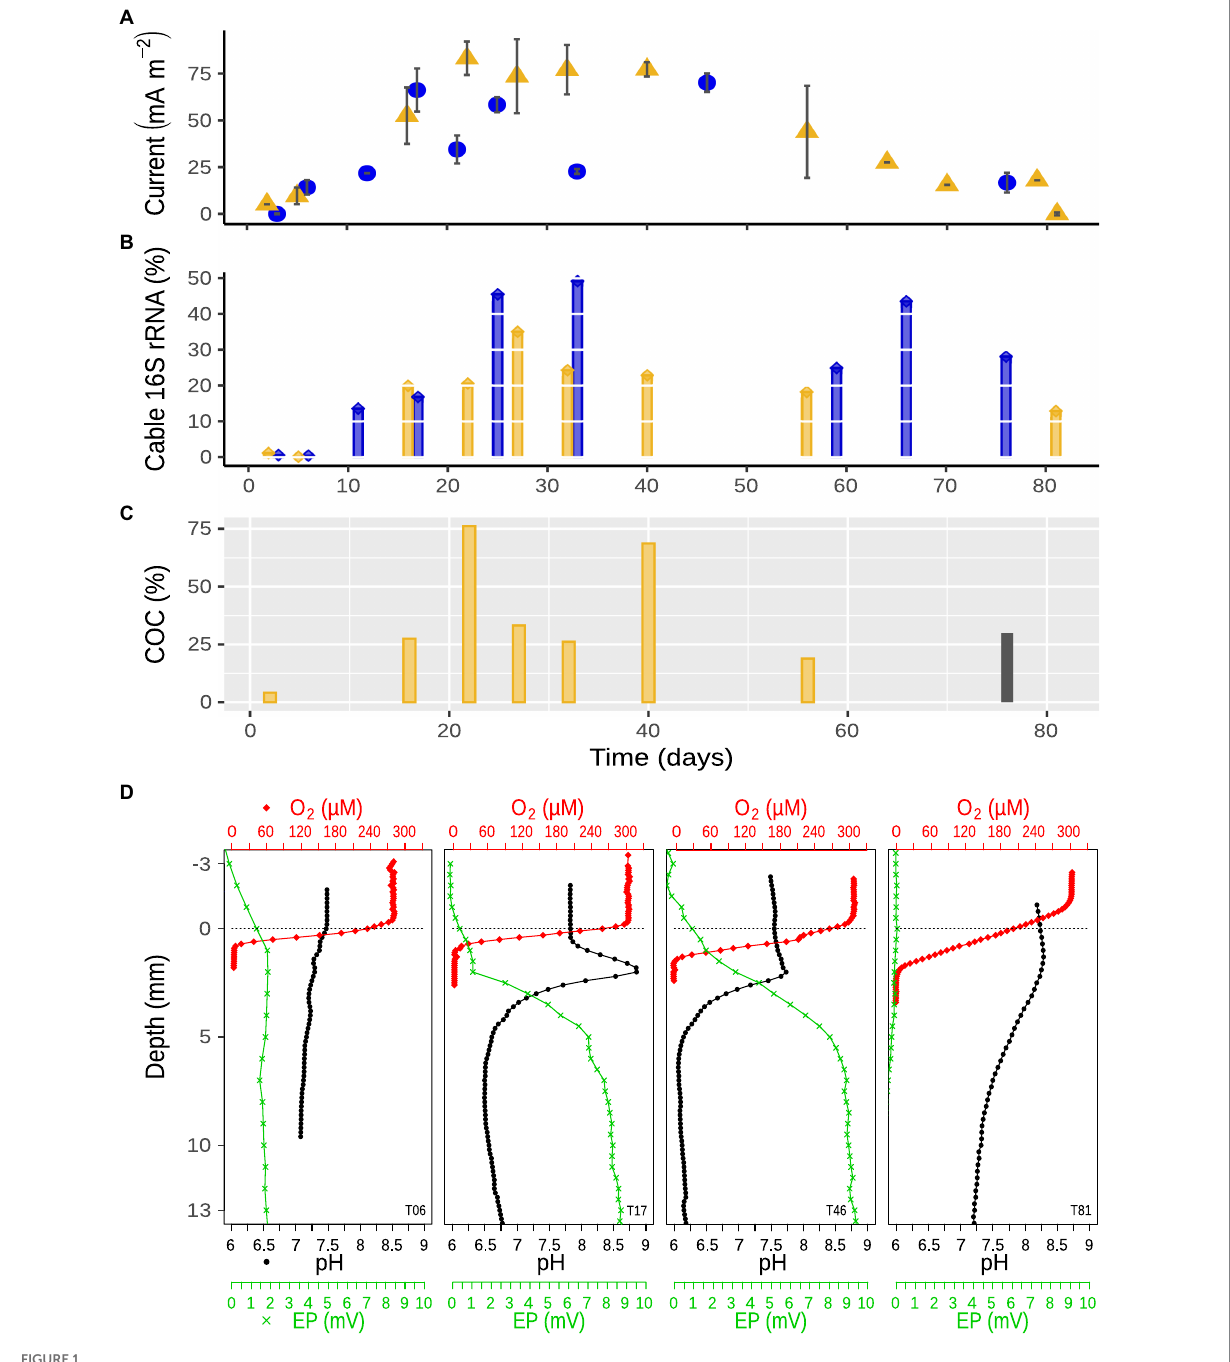
FIGURE 1 (A) Cable bacteria activity over 81 days of incubation displayed in current density (mean ± SD, n = 1–3 pairs of up and down microprofiles) between sediment surface and maximum EP within the sediment; blue circles, first time series (TS1); yellow triangles, second time series (TS2). (B) Relative abundance of cable bacteria 16S rRNA in anoxic zone over time; blue, first time series (TS1); yellow, second time series (TS2). (C) Cathodic oxygen consumption (COC) of cable bacteria over time calculated from the cores sampled for microscopy during TS2 (yellow); gray, calculated from TS1. (D) Examples of depth profiles of oxygen (red diamonds), pH (black dots), and EP (green crosses) at day 6, 17, 46 (TS1), and 81 (TS2). The dotted gray line indicates the sediment